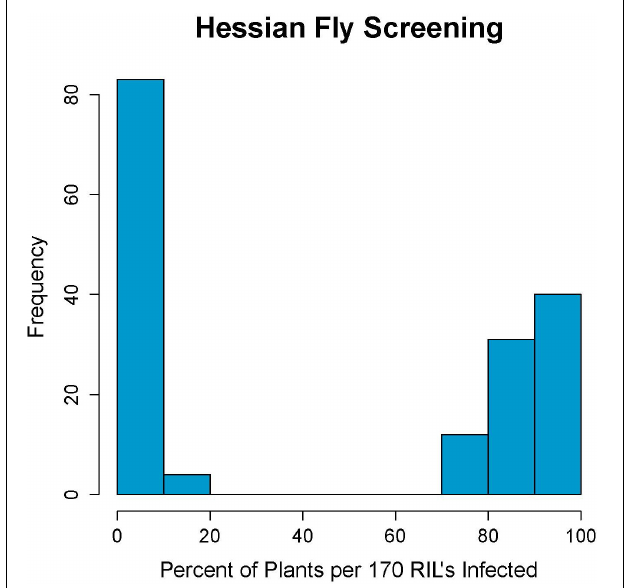
FIGURE 1 | Hessian fly screening results of the 180 recombinant inbred line population created from the cross of Scarlet and Kelse. Results show a strong bimodal distribution for Hessian fly resistance, indicating a single causative locus.